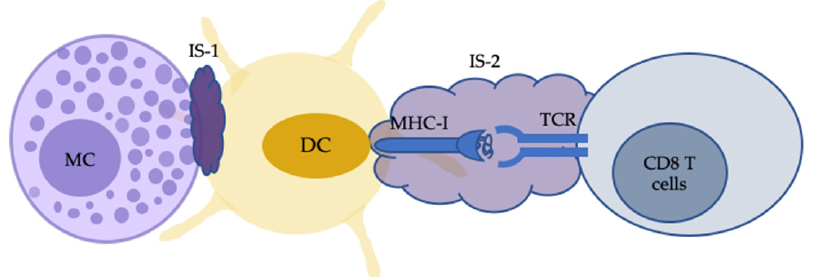
Figure 2. Indirect MC-CD8 T cell interactions can also occur with the antigen cross-presentation by dendritic cells (DCs). Activated MCs, following IgE–Fc ε RI crosslinking with antigen, can trigger the formation of an immunological synapse (IS) with immature DCs (IS-1). The IS facilitates the transfer of MC-internalised antigens from MCs to DCs. DCs then process and present the transferred material to CD8 T cells with IS-2 for cell activation. MC, mast cells.